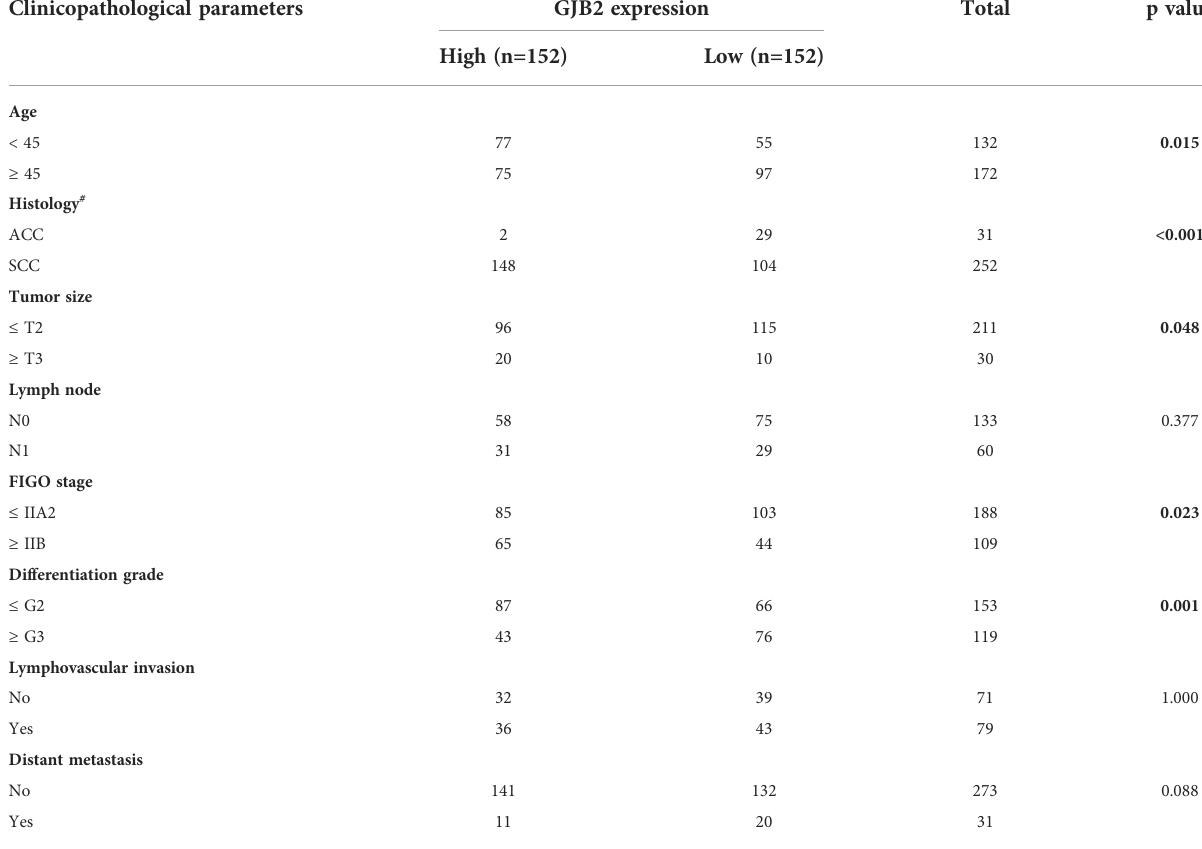
TABLE 2 Relationships between GJB2 expression and clinical factors in cervical